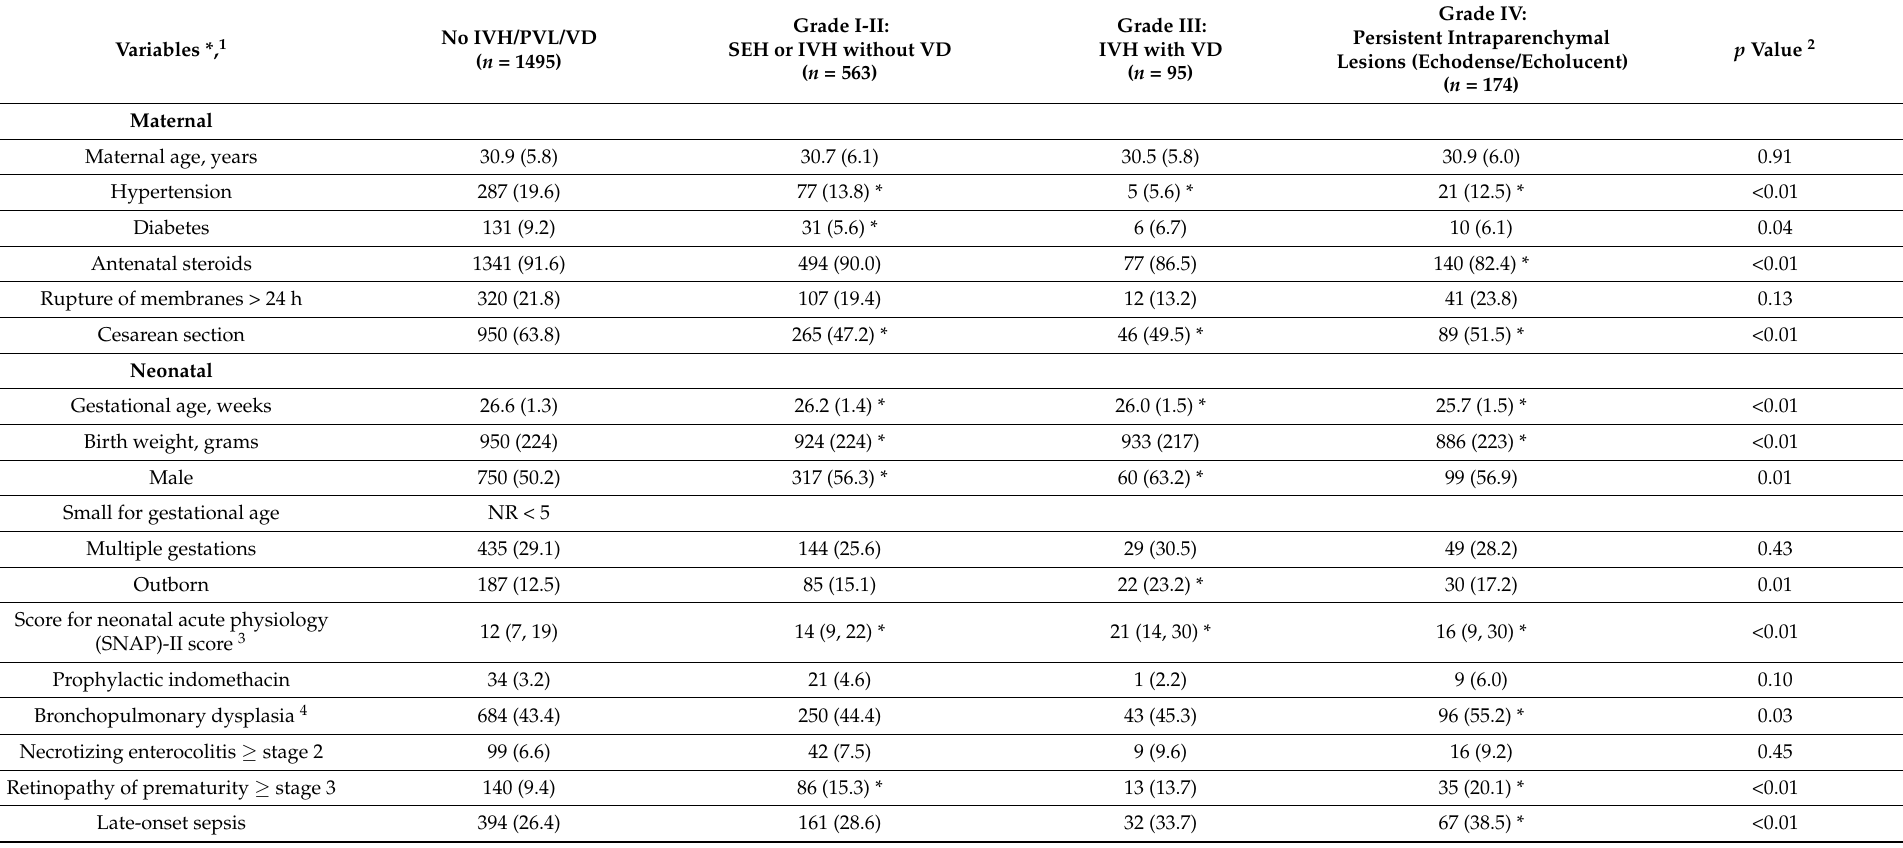
Table 1. Baseline characteristics and clinical outcomes of IVH